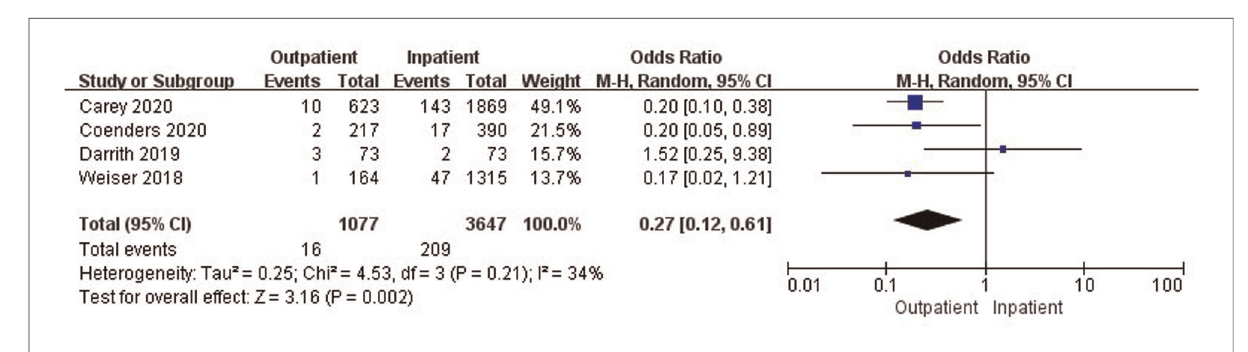
FIGURE 7 Comparison of 90-day readmissions between outpatient and inpatient